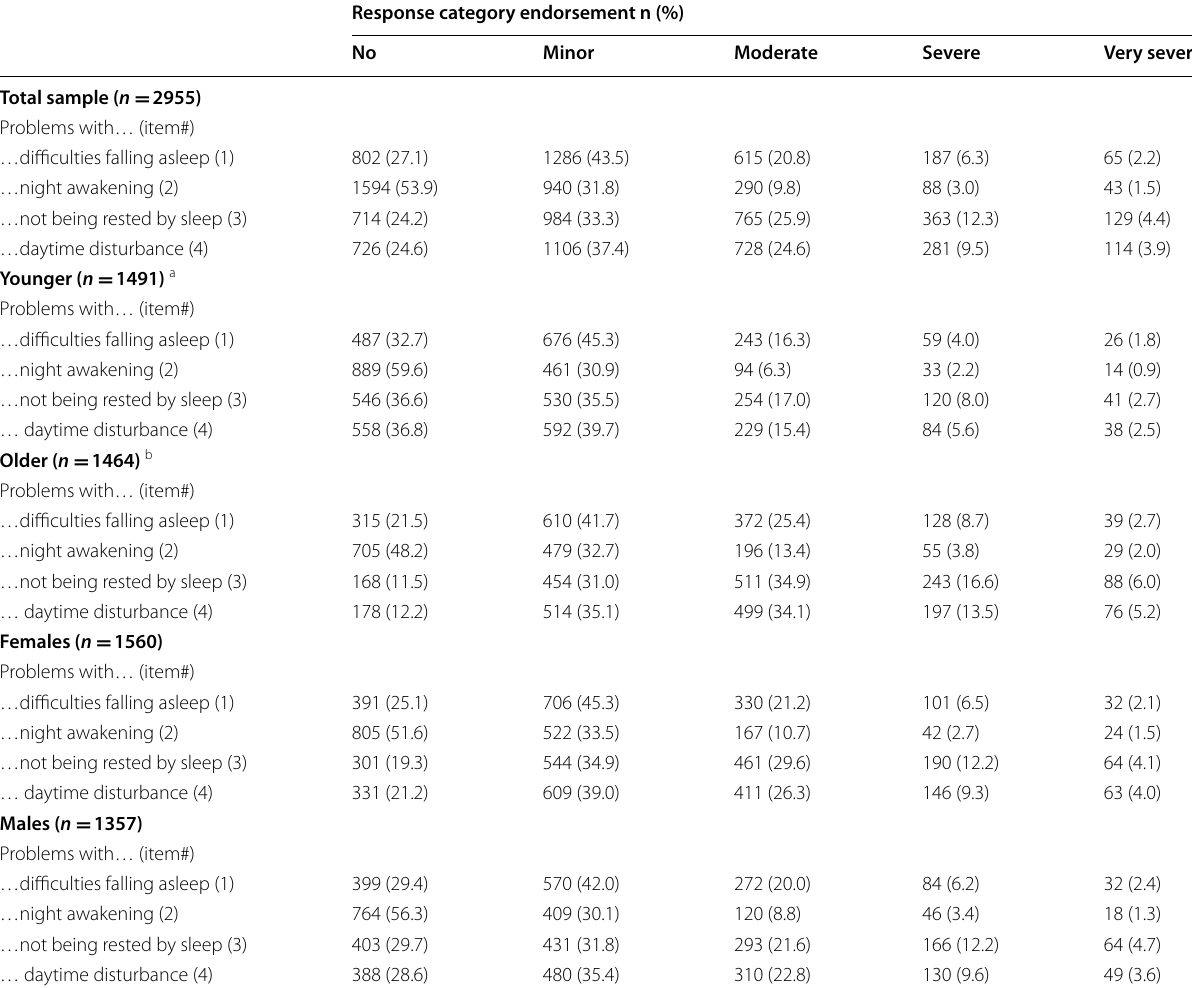
Table 2 Item response rates for the Minimal Insomnia Symptom Scale (items 1–3) and the new item “daytime disturbance” (item 4)